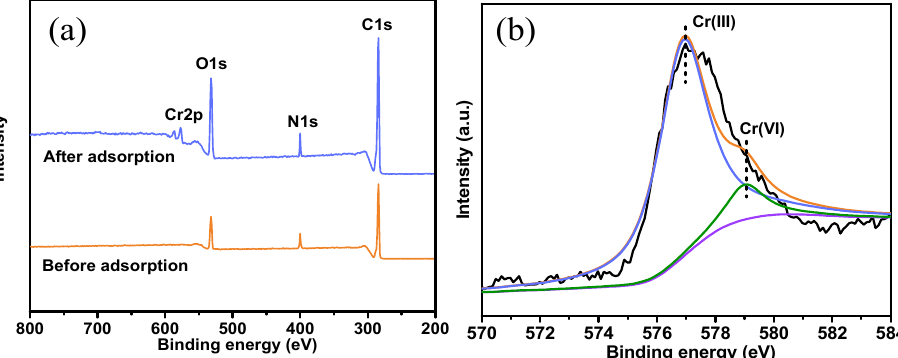
Figure 9. ( a ) XPS spectra of DAPFP, DAPFP-Cr; ( b ) XPS high-resolution scan of DAPFP after Cr (VI) adsorption.